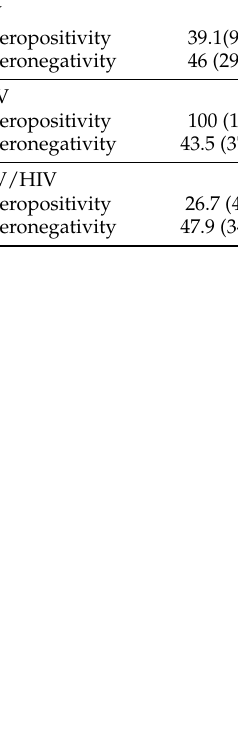
Table 4. Association of ovarian cancer patients’ HBV serological status with their clinical